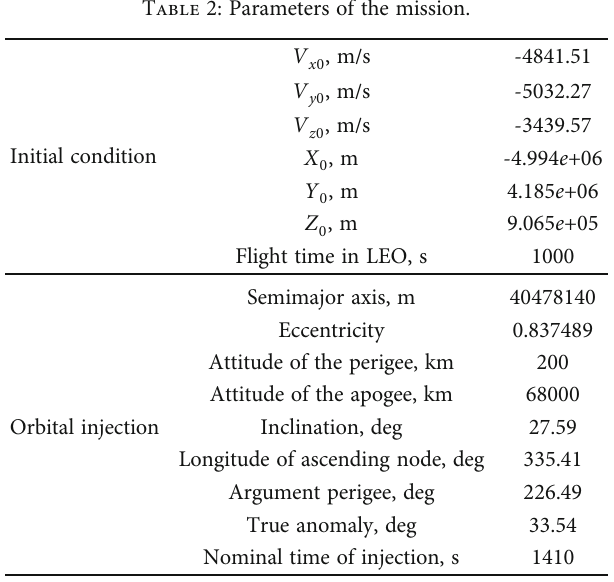
Table 2: Parameters of the mission.